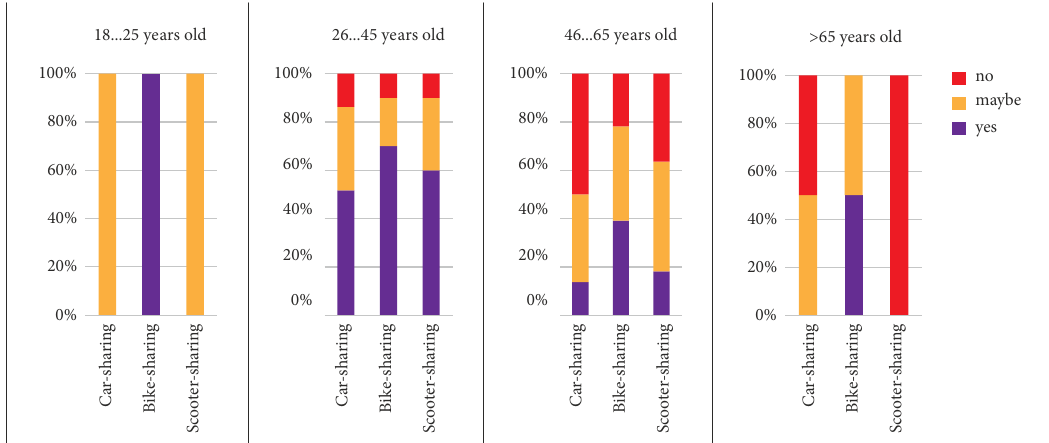
Figure 3. Distribution of tourists answers whether they would use a vehicle-sharing system at the resort by the type of transport mode and by age group